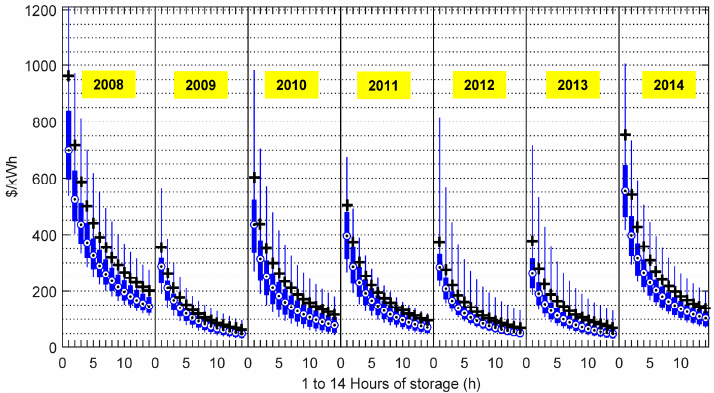
Figure 23. Distribution of breakeven overnight installed cost in the PJM RT-Market for an ESS vs. discharge duration at rated power (1–14 h) for each of the years studied. The thin vertical bars represent the entire range over the 7395 nodes. The thick vertical bars are bounded by the 25th and 75th percentile of the nodes. The circles represent the 50% percentile of the nodes and the black crosses indicate the 95th percentile of the nodes. Assumed round trip efficiency is 90% and project lifetime is 20 years.